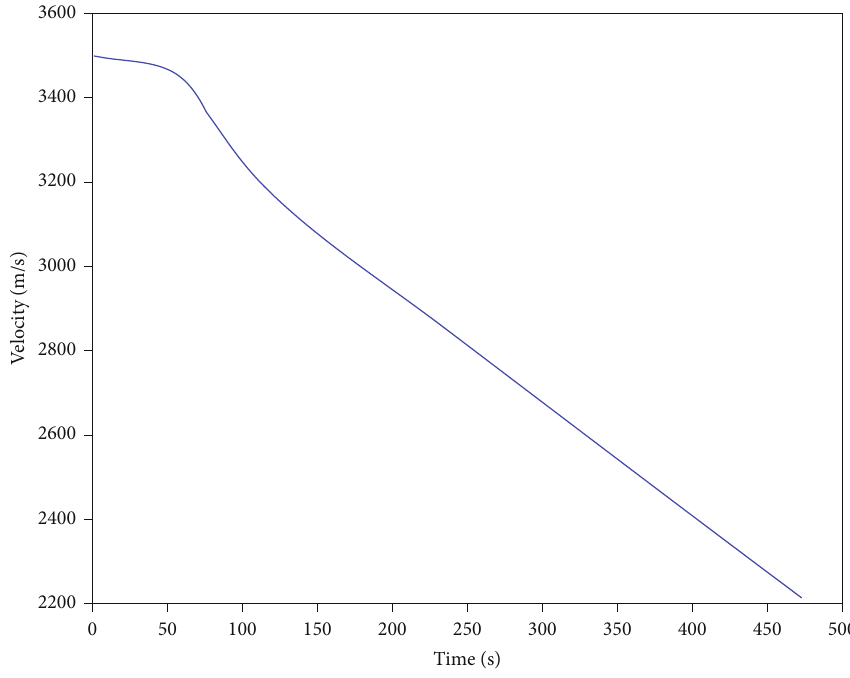
Figure 2: The velocity curve of a